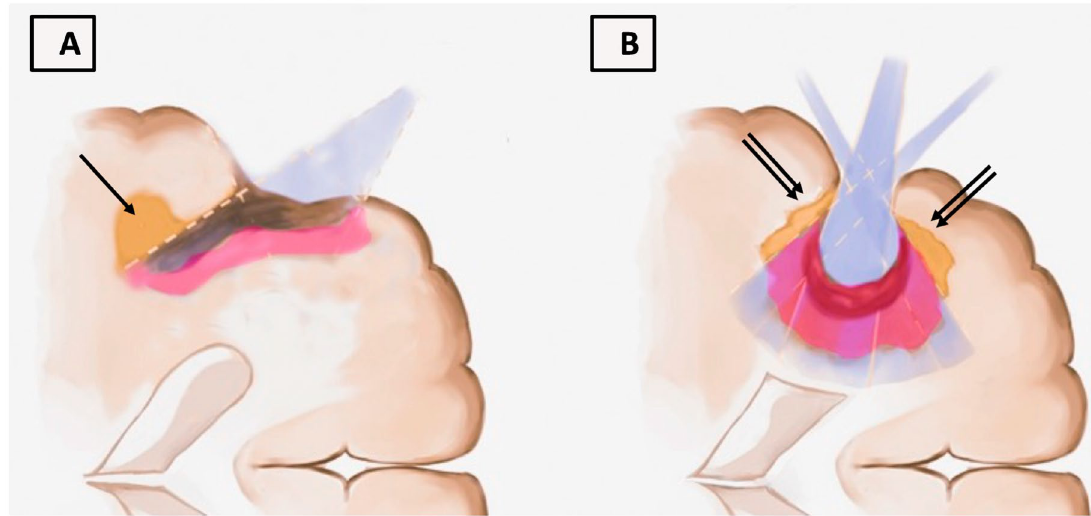
Figure 4. Long working corridors, deeply seated or irregularly shaped lesions, and surgical cavity edges can create dark corridors not allowing the microscope to elicit fluorescence from pathological tissue. ( A ) Shows the difficulties in identifying the remnants on the top left of the resection cavity (arrow). ( B ) During the final inspection, the microscope should be angled to extreme positions (double arrows) to achieve a complete exploration of surgical cavity